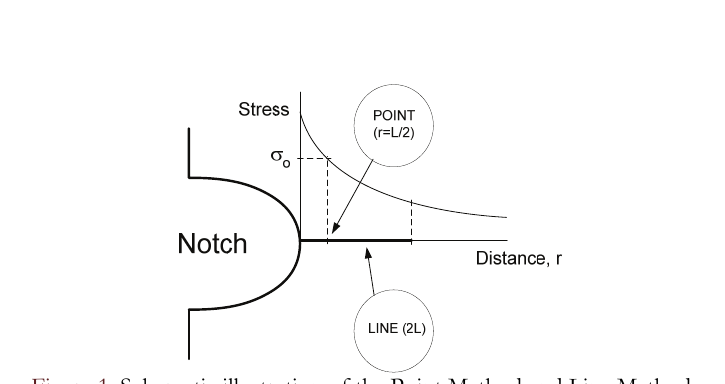
Figure 1: Schematic illustration of the Point Method and Line